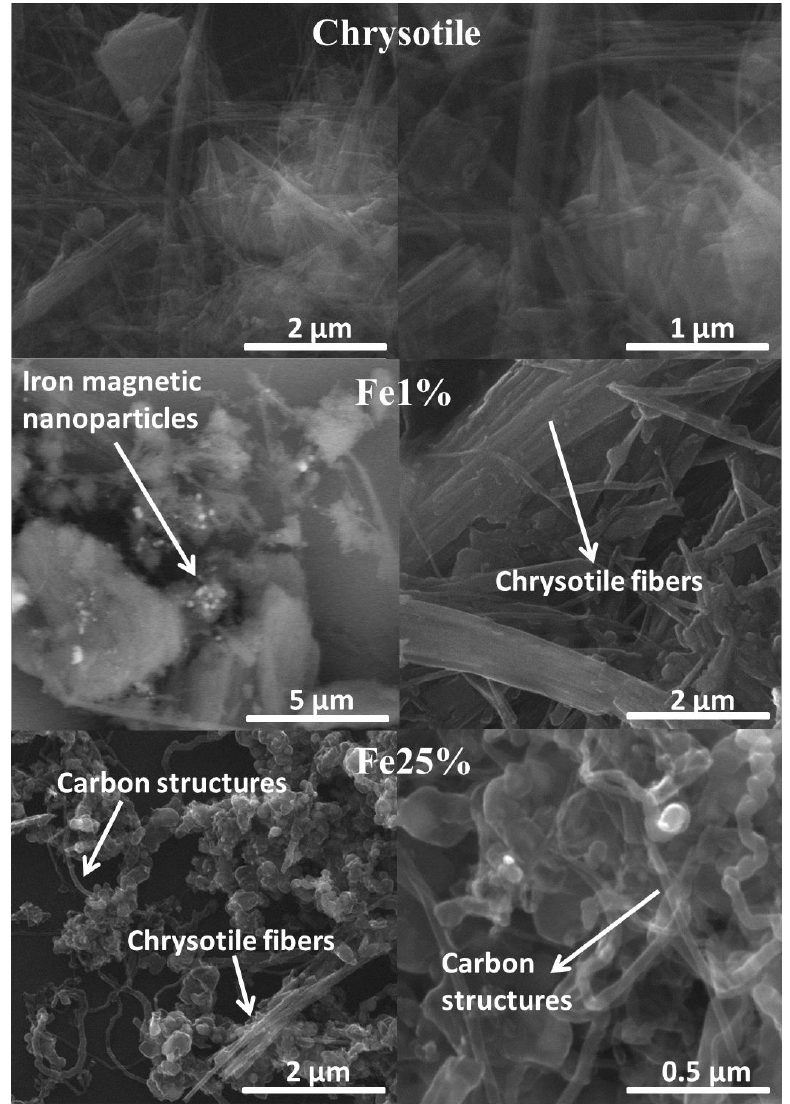
Figure 2. SEM images of chrysotile and magnetic amphiphilic nanoparticles (Fe1% and